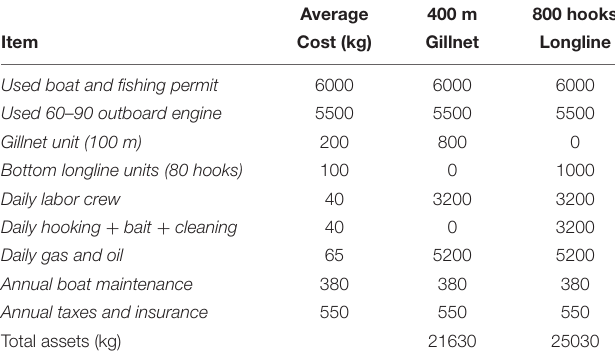
TABLE 6 | Estimated unit cost (in kilograms of fish equivalent) for operational gillneting considering the average fishing effort, the catch rate for each gear during the experiment, and comparable fishing efforts between gears in BSB (400 m gillnets and 800